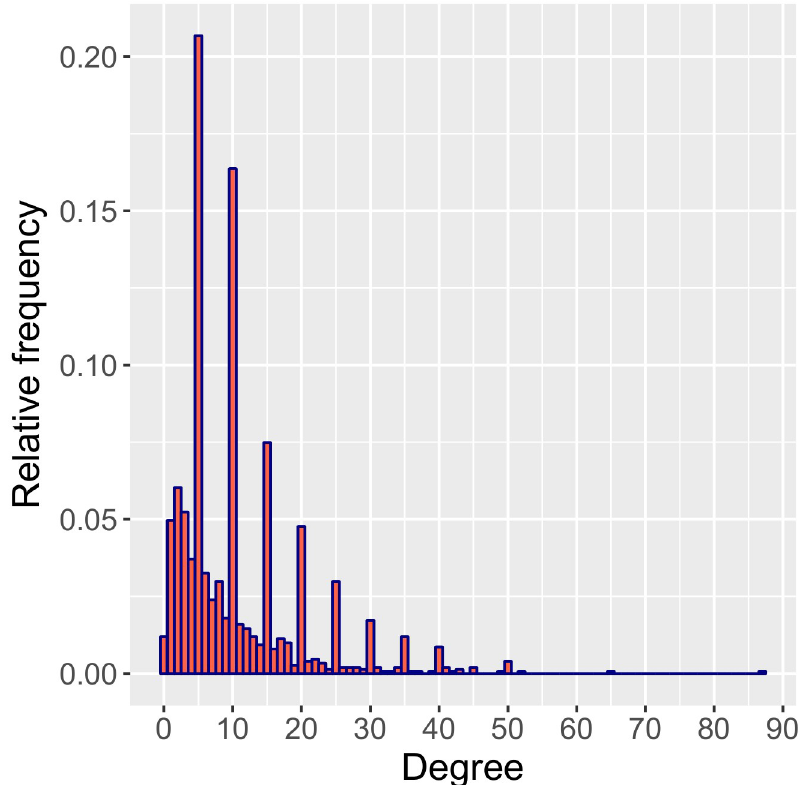
Fig 1. The observed degree distribution for the morning the day before the survey. The spikes result from rounding to multiples of